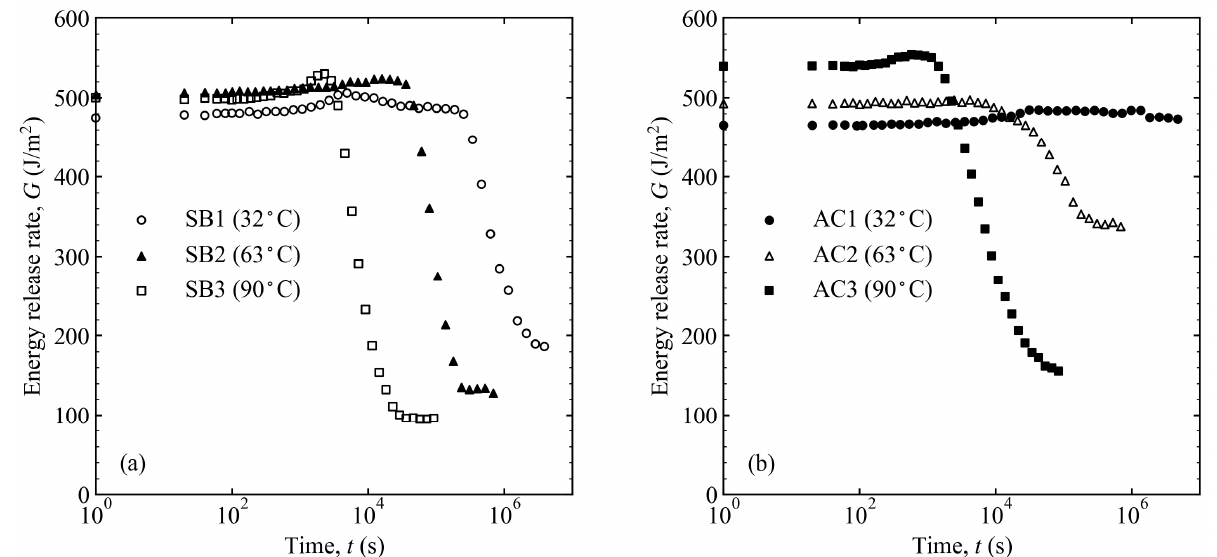
Figure 10. Energy release rate variation over time at different temperatures and surface treatments: ( a ) sandblasting and ( b ) pickling.